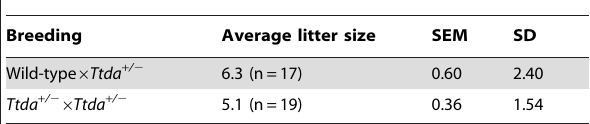
Table 2. Average litter